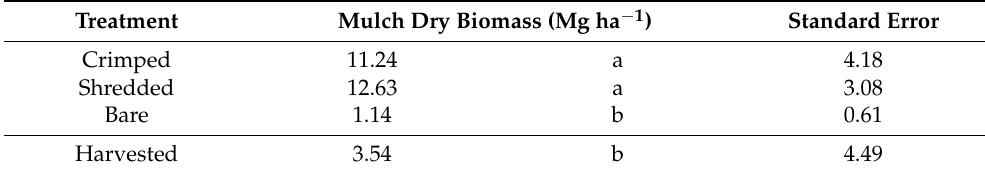
Table 4. Result of statistical analysis on mulch dry biomass.